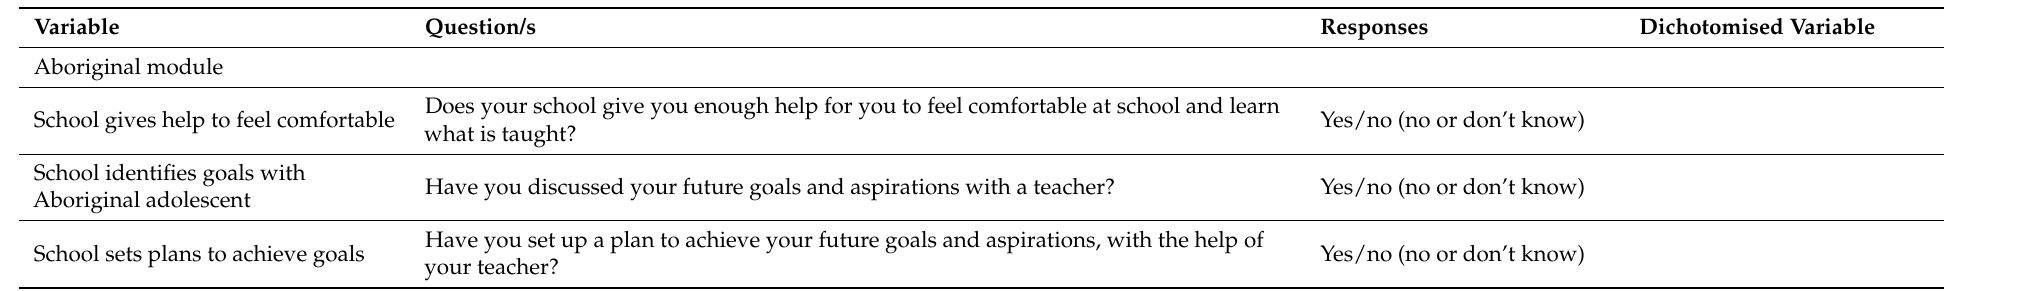
Table A2. Collection and measurement of structural